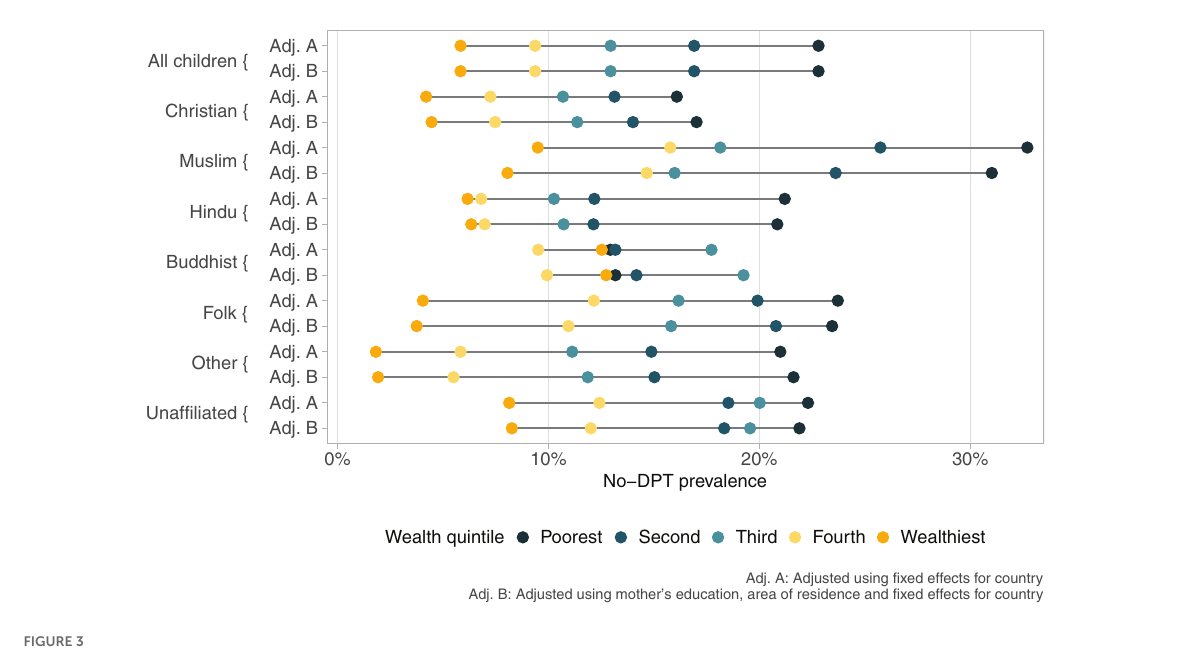
FIGURE3 No-DPT prevalence according to religious group and wealth quintiles. Poisson regressions with children as the units of analyses, including fixed effects for country.